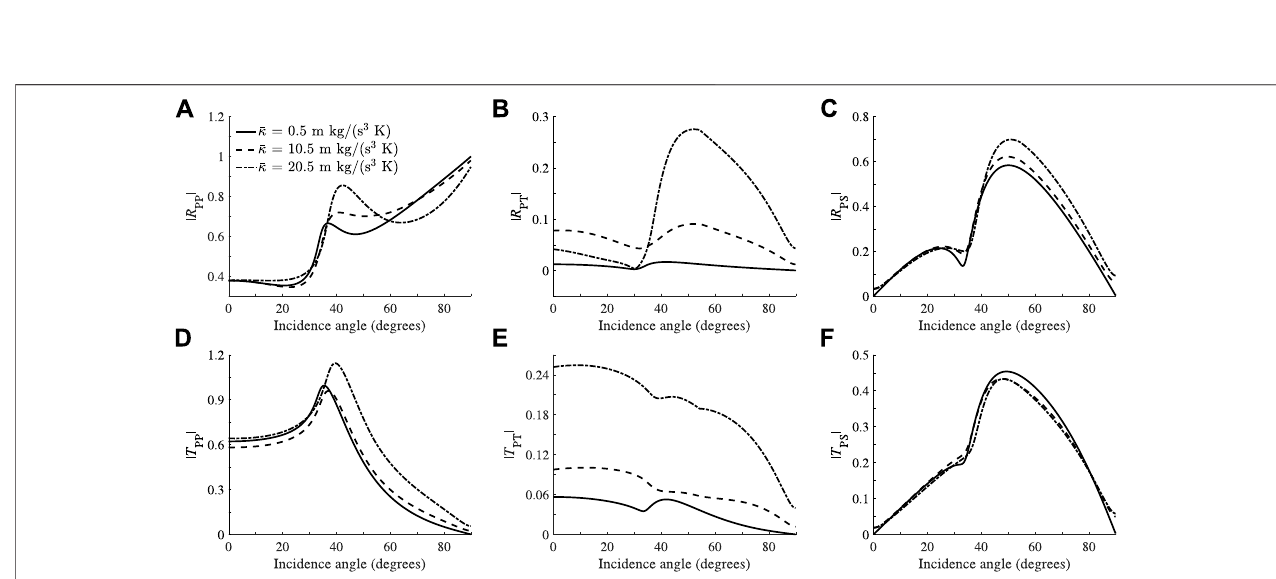
FIGURE12| Absolutevaluesofthere fl ected P (A) ,re fl ectedT (B) ,re fl ectedS (C) ,transmittedP (D) ,transmittedT (E) andtransmittedS (F) wavesasafunctionof the P-wave incidence angle at 100 MHz and γ 0 = 40 ° , where we vary the thermal conductivity of the incidence media.